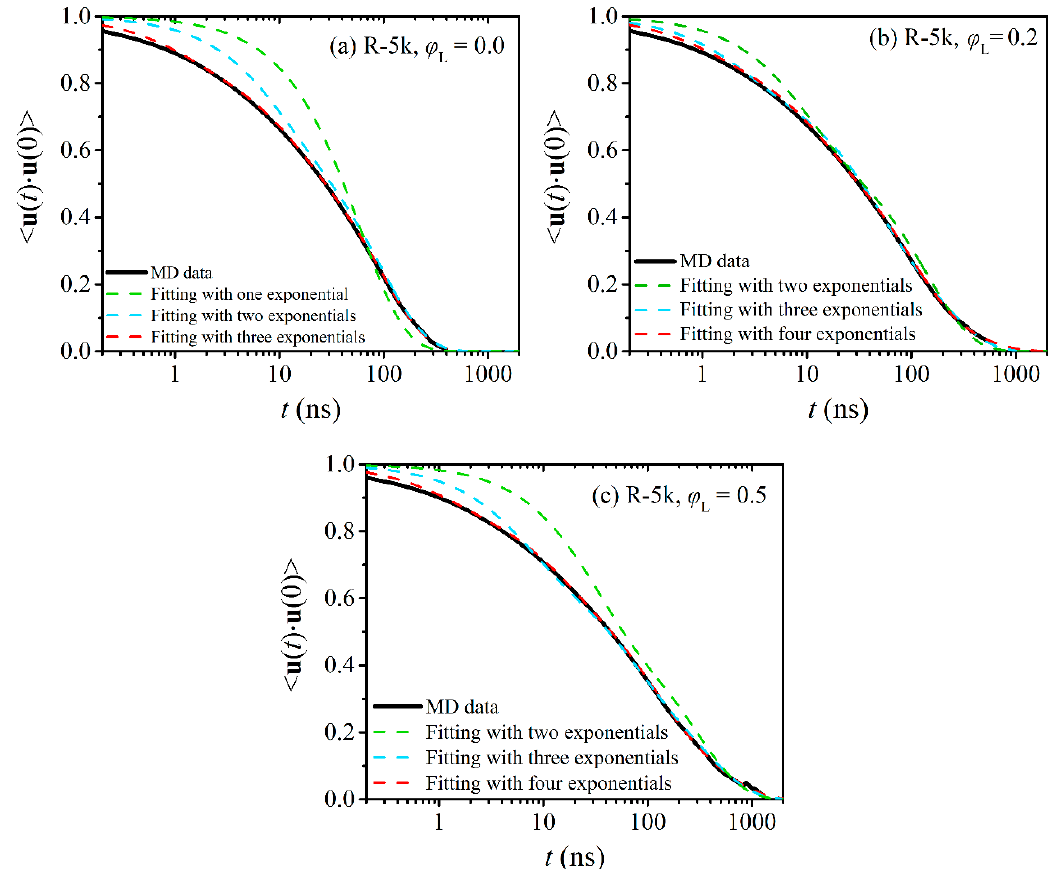
(cid:10) (cid:11) ( ) ( ) u ( t ) · u ( 0 ) describing relaxation at the level of the ⋅ t 0 u u describing relaxation at the level of the